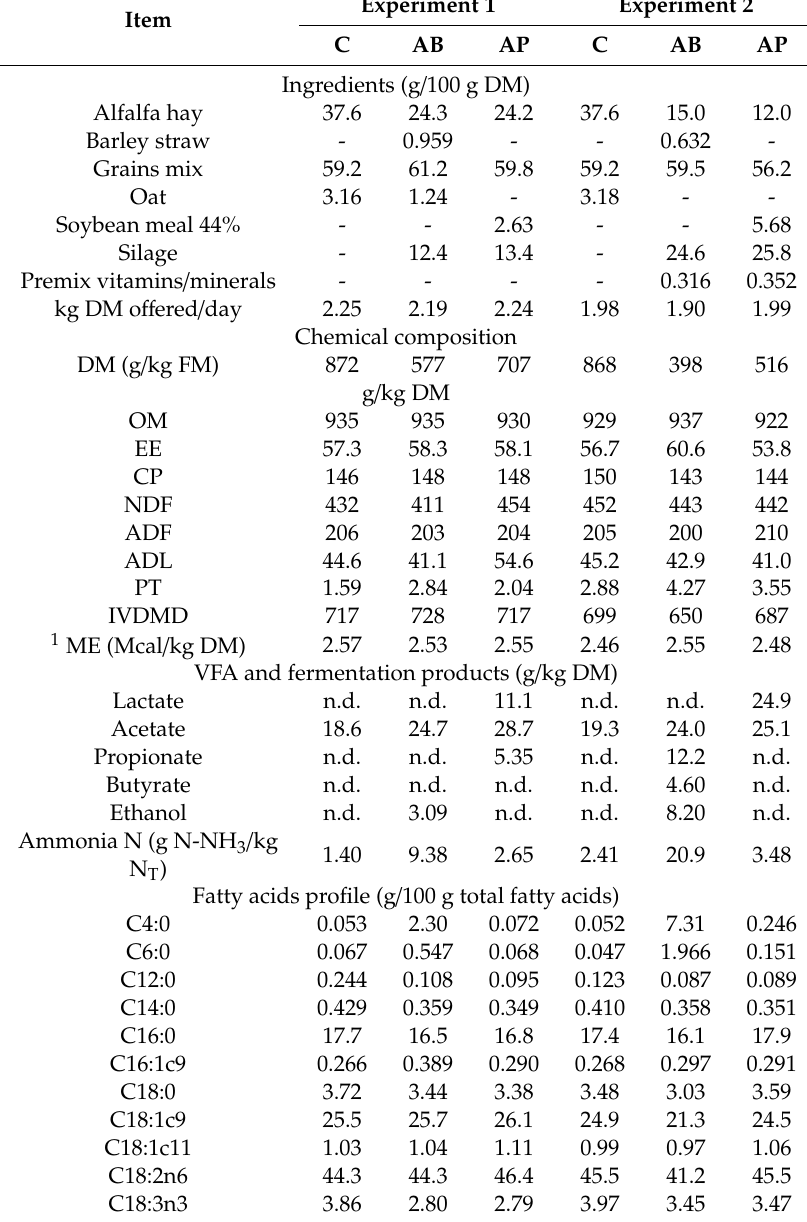
Table 1. Ingredients and chemical composition of the experimental